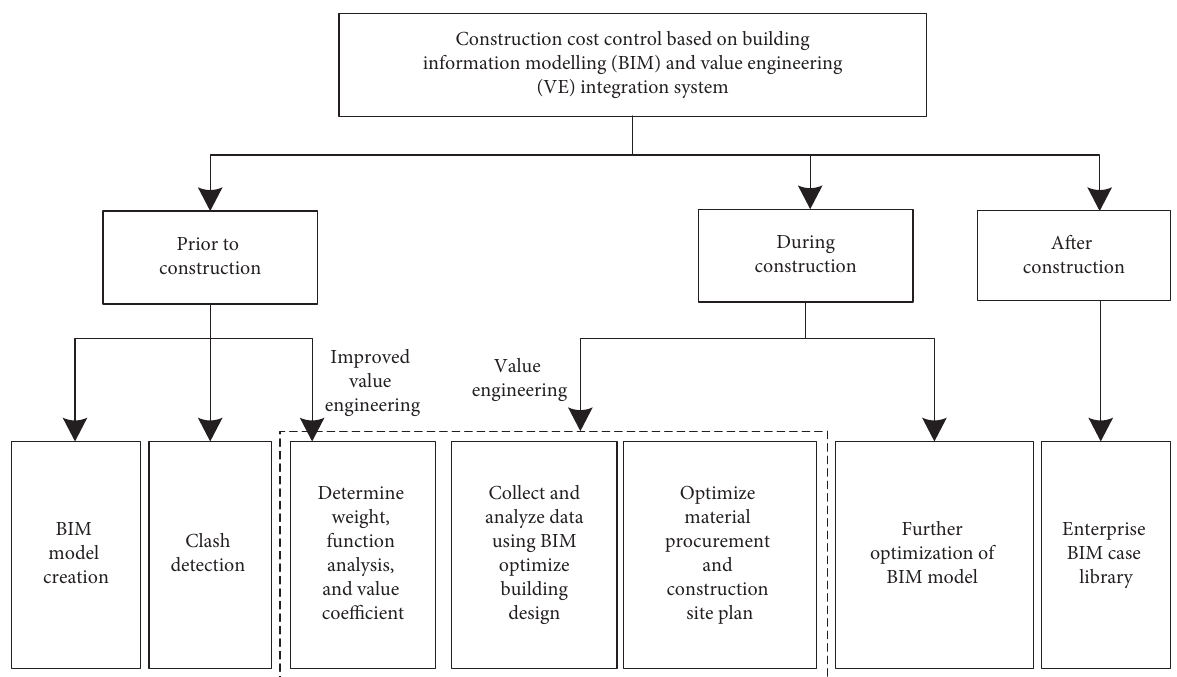
Figure 1: The construction cost control framework based on BIM and VE